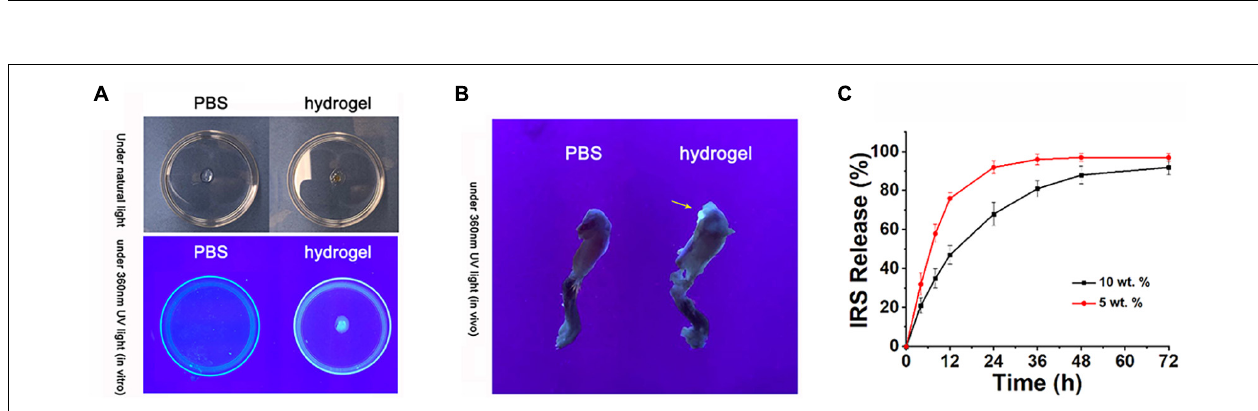
Frontiers in Cell and Developmental Biology |